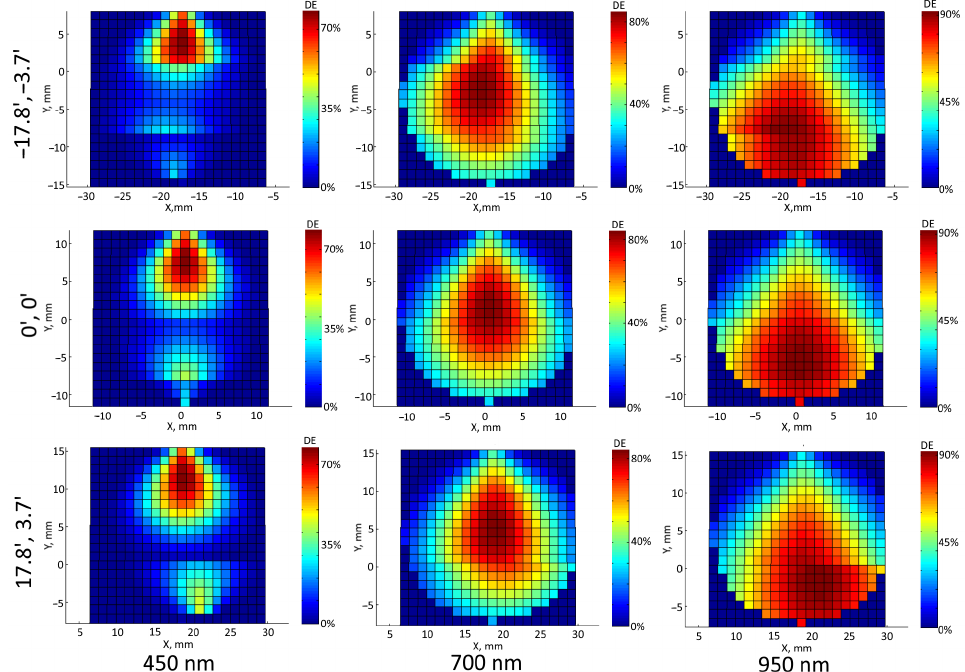
Figure 9. Spatial distribution of the DE across the beam footprint for the composite